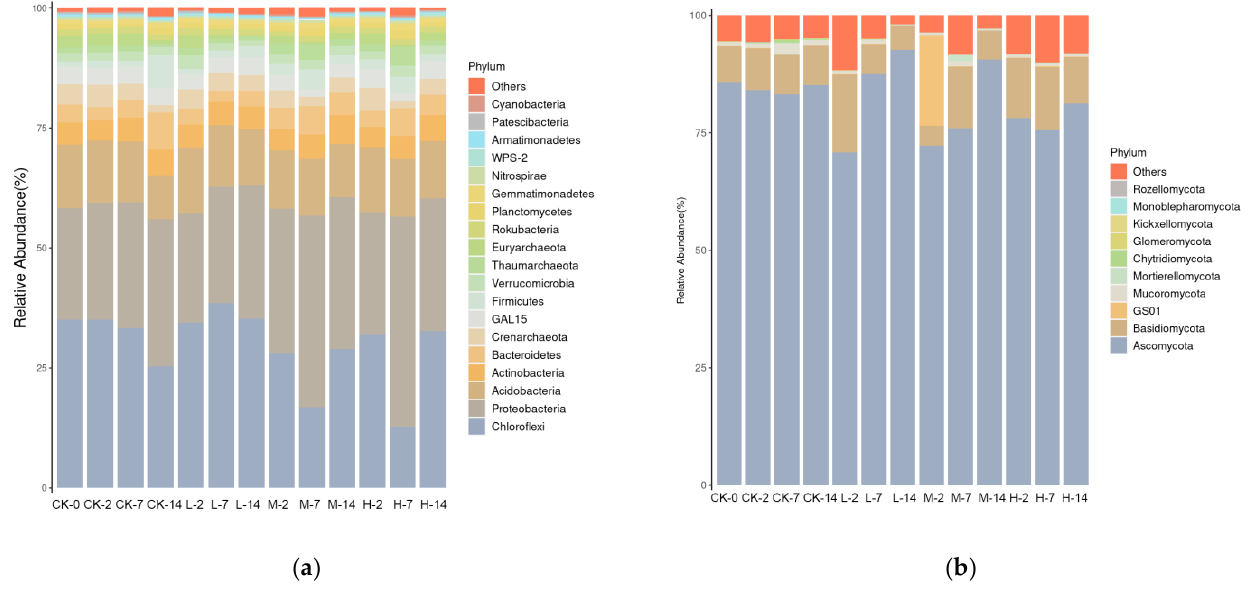
Figure 7. Relative abundance of the dominant bacteria ( a ) and fungi ( b ) at the phylum level.